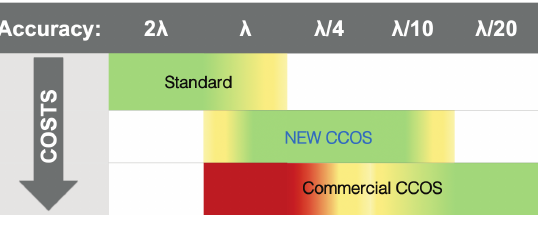
Table 1. Capability versus cost